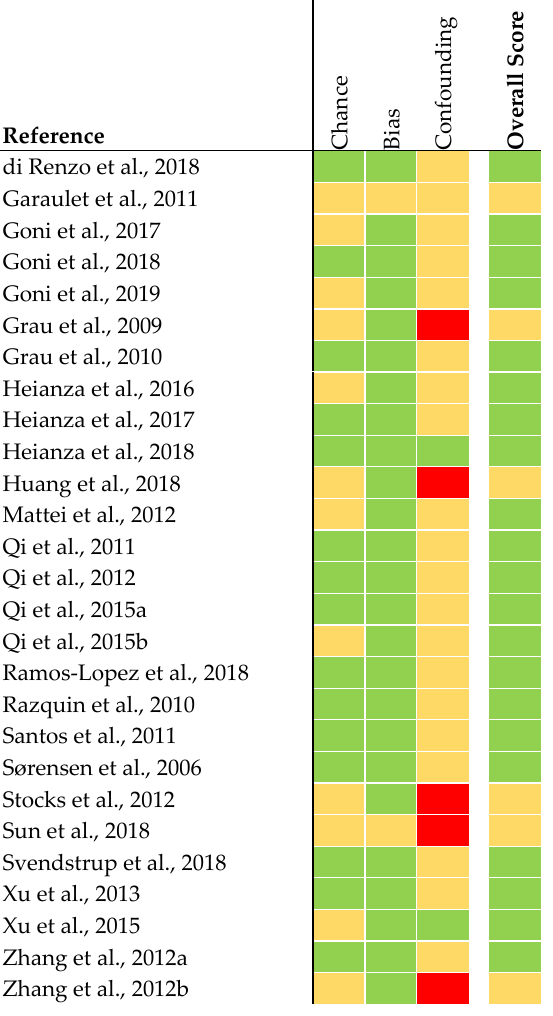
Figure 3. Quality assessment of genetic association studies [28] . The quality was judged as rather high (green), intermediate (yellow), or low (red).